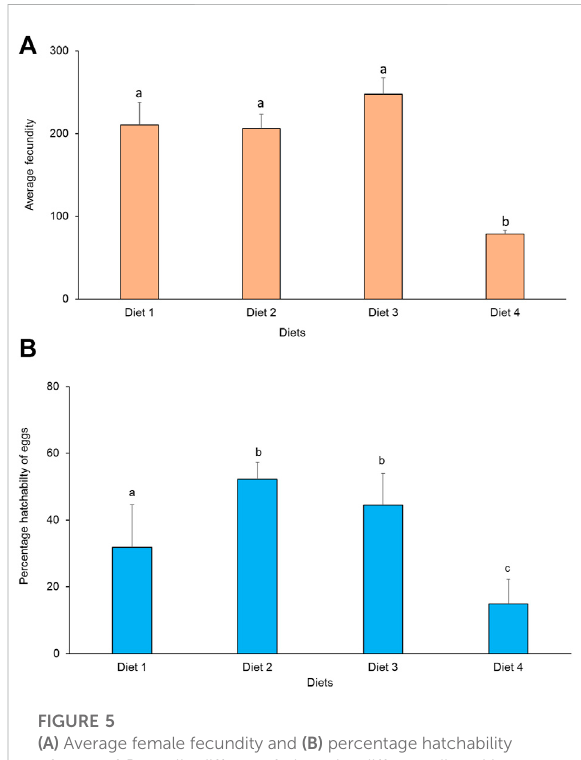
FIGURE 5 (A) Average female fecundity and (B) percentage hatchability of eggs of Ruspolia differens fed on the different diets. Means capped with different letters differed signi fi cantly (Tukey HSD, p < 0.05).